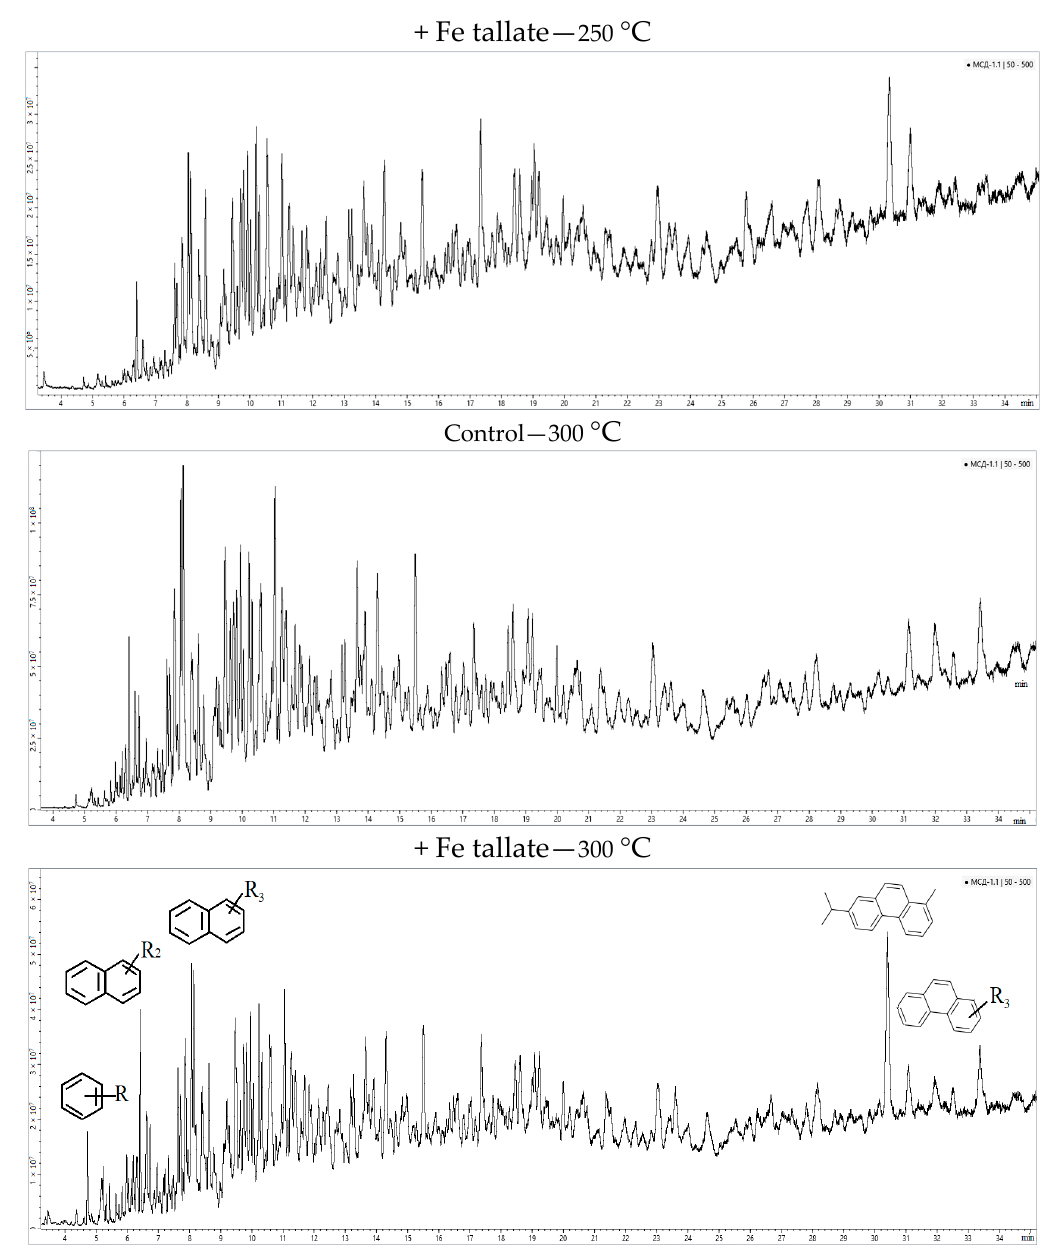
Figure 13. Total ionic current (TIC) chromatograms of aromatic fraction.